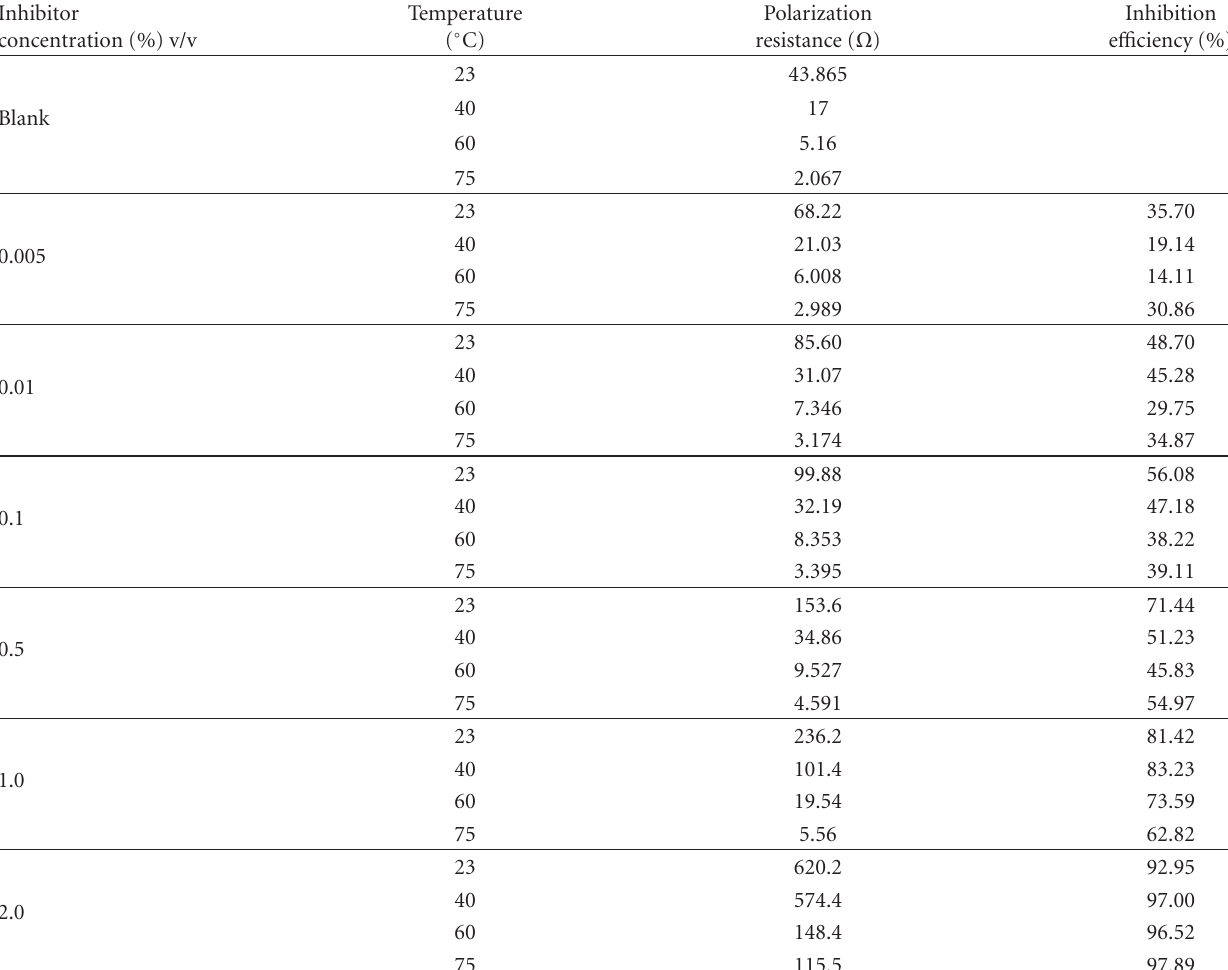
Table 4: Polarization resistance values for carbon steel in 1M HCl at di ff erent temperatures obtained by electrochemical measurements in the absence and presence of EEPD in various